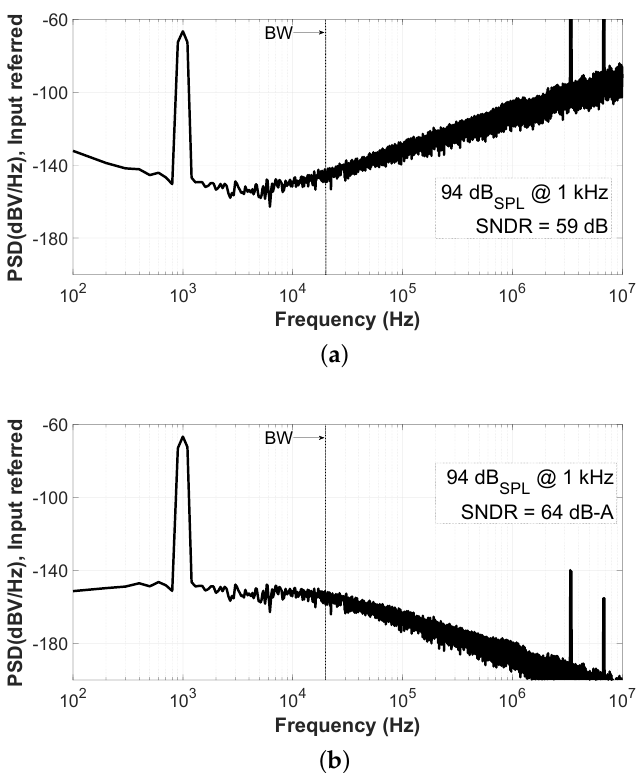
Figure 13. Measured spectrum for an input signal of 94 dB SPL (12 mV rms ) at 1 kHz: ( a ) Non-A-Weighted; ( b )